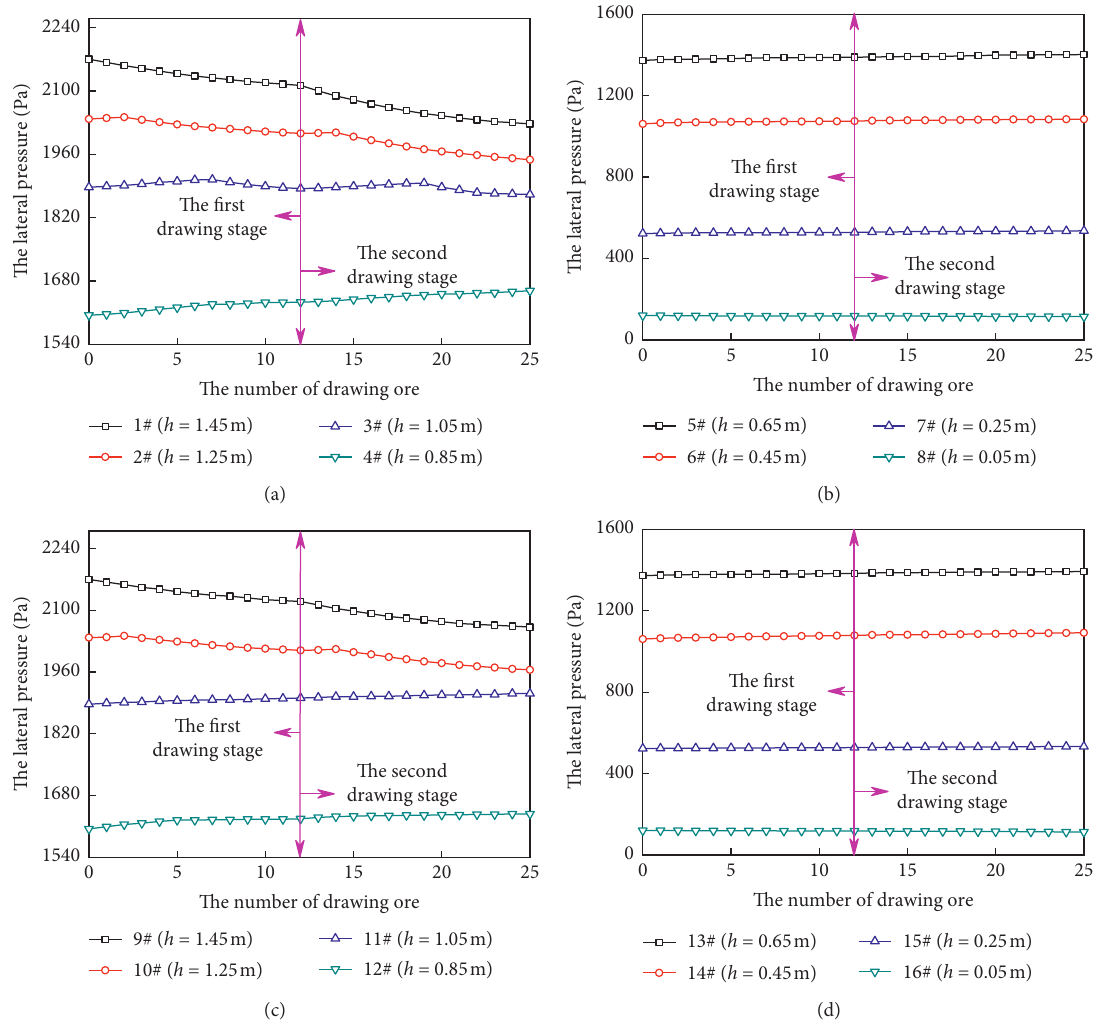
Figure 12: The relationship between the number of drawing ore and the values of lateral pressure with scheme